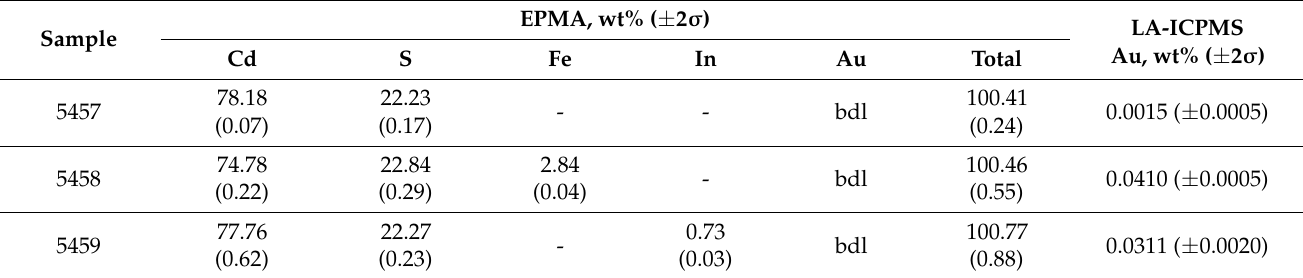
Figure 40. Microphotos of the synthetic sphalerite crystals with native gold dendrites, synthesised using the salt flux method (sample 1662). Table 28. Chemical composition of greenockite crystals with admixtures of Fe, In and Au, synthesised using the gas transport method at 850 °C.